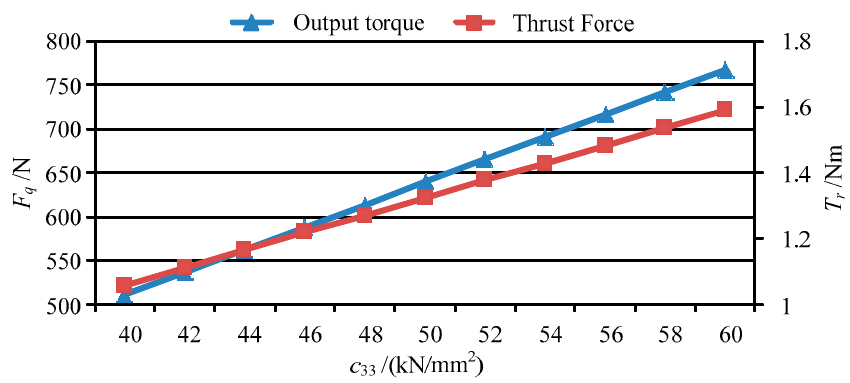
Figure 15. The output torque and thrust force vary with c 33 .